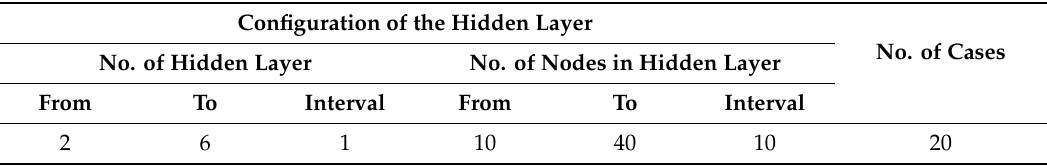
Figure 4. Histogram of training data: ( a ) ore production; ( b ) crusher utilization.